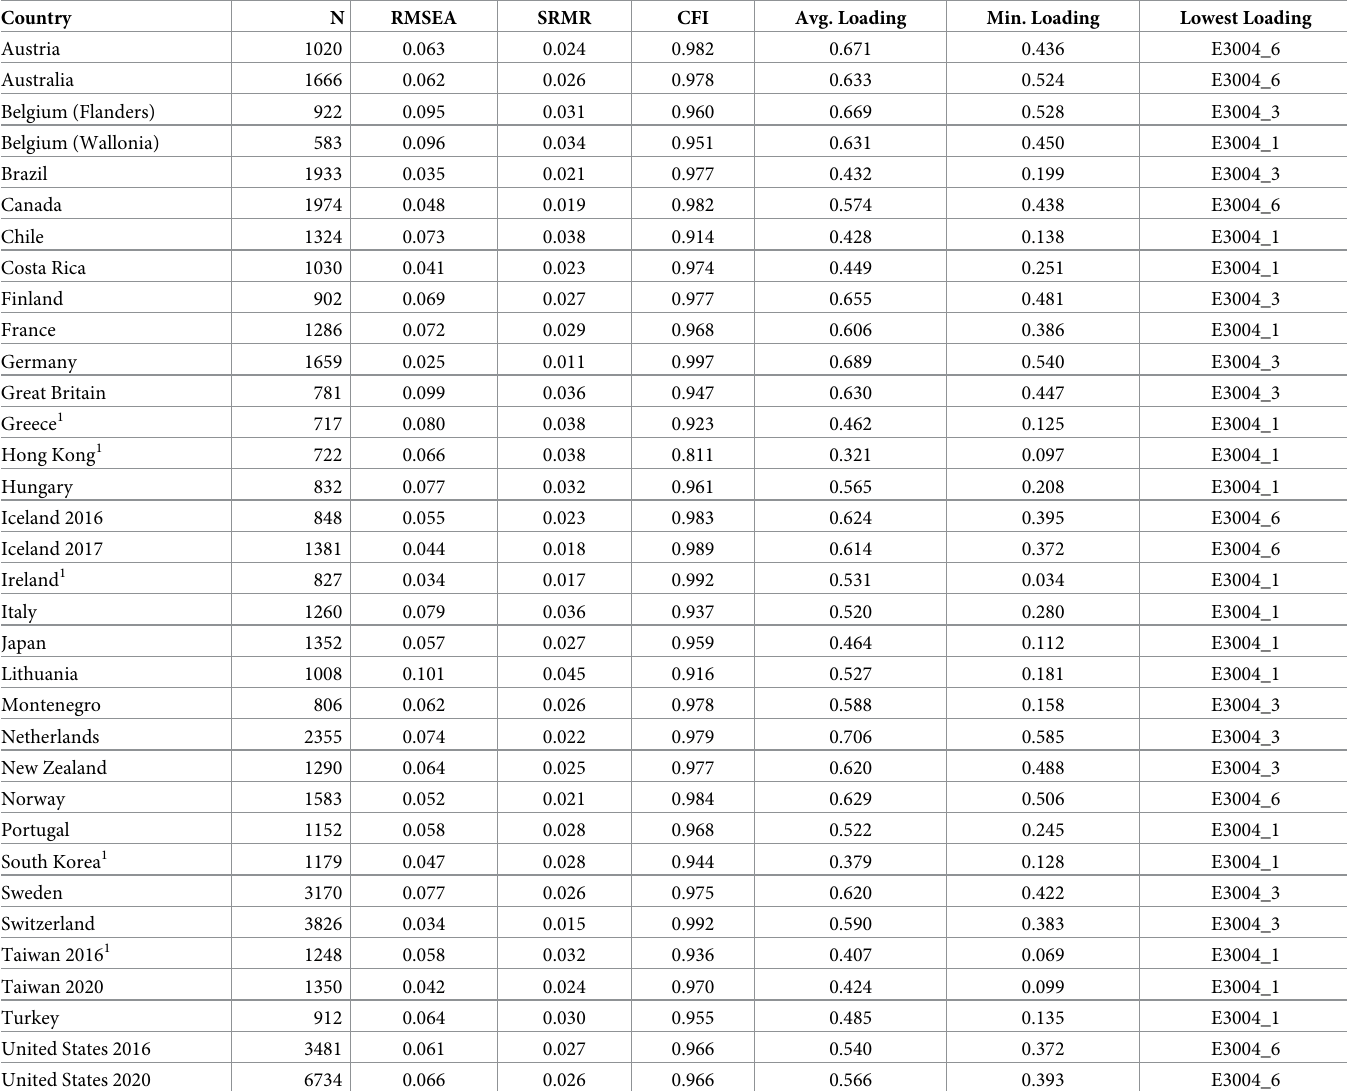
Table 2. Confirmatory factor analysis models Castanho Silva et al. version (one